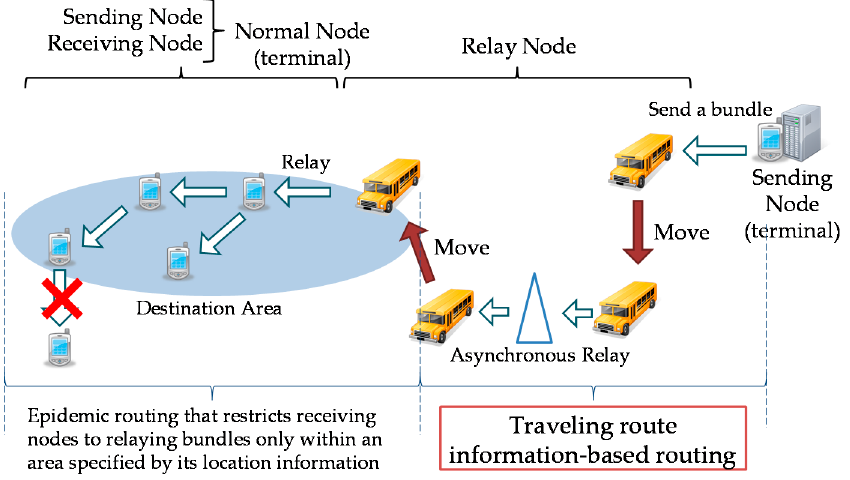
Figure 2. Traveling route information ‐ based routing and local content delivery.